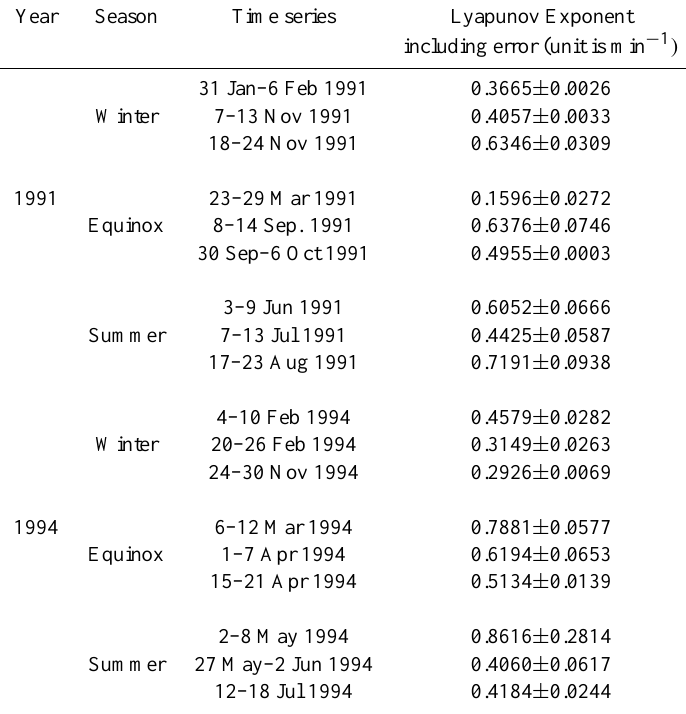
Table 3. Values of Lyapunov exponent for time series of AE index during storm